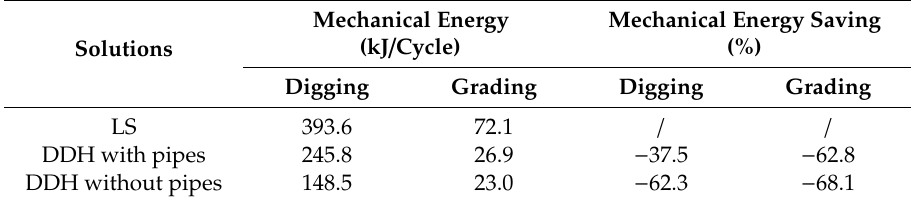
Table 5. Mechanical energy supplied by diesel engine (for DDH solutions the diesel engine is connected to the